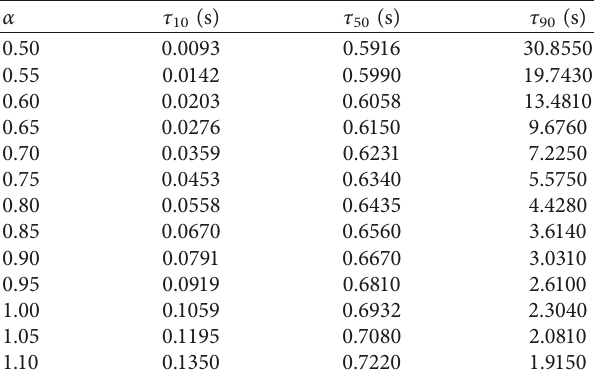
Table 2: Numeric values of normalized times τ